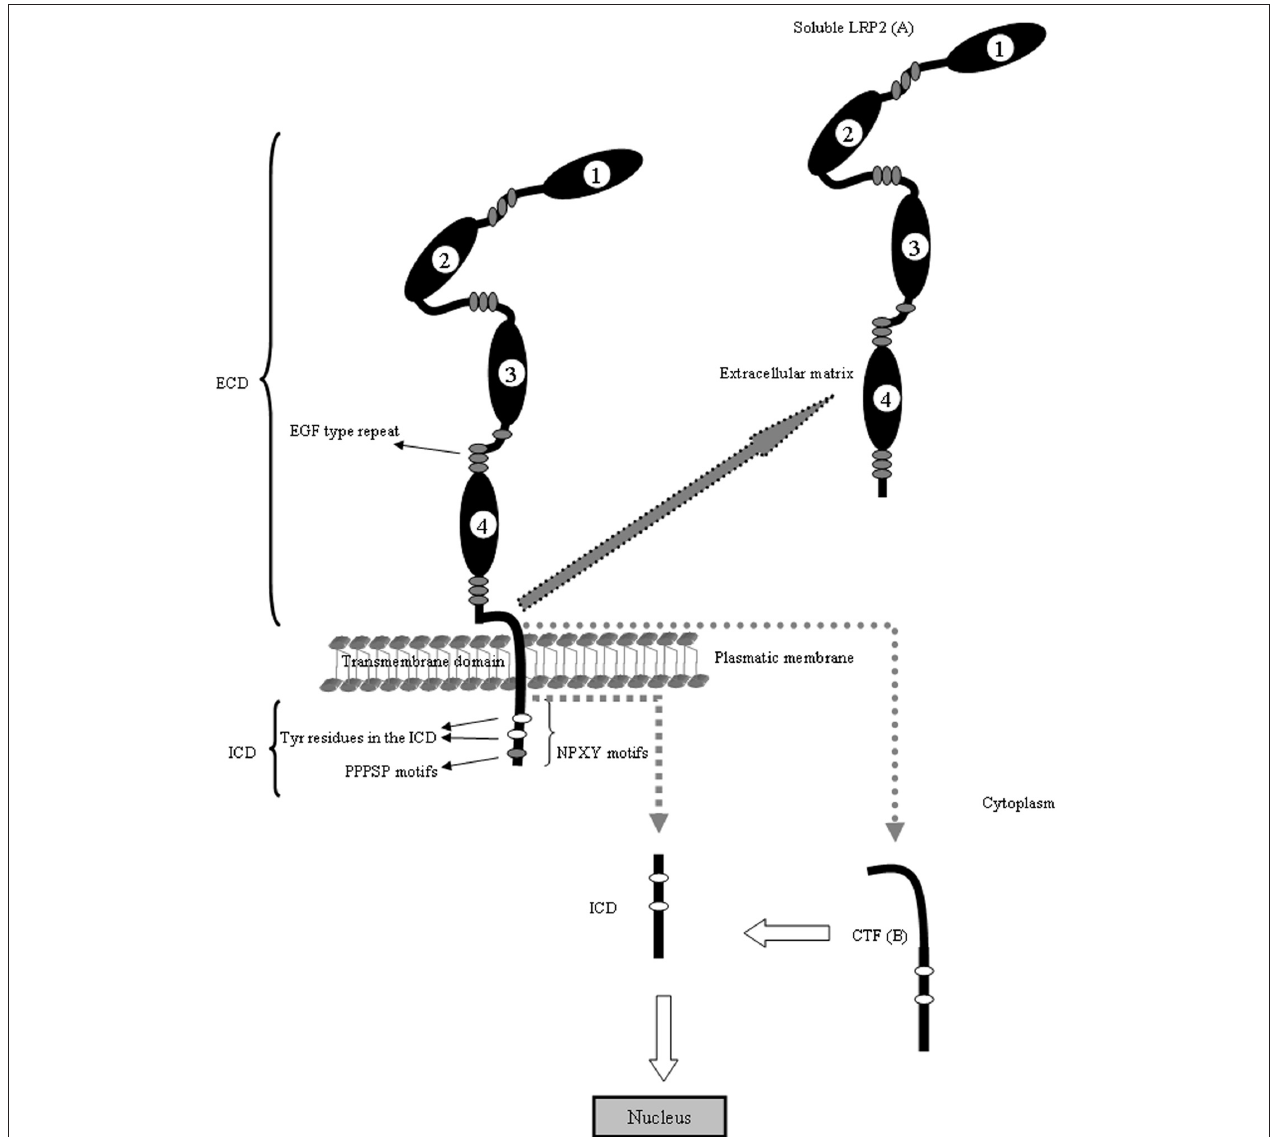
FIGURE 2 | LRP2 is structurally similar to LRP1. The ECD of LRP2 contains four clusters (1–4) of lipoprotein receptor ligand-binding repeats, growth factor repeats, an EGF repeat, and YWTD spacer regions. Interestingly, the second cluster has been identified as a common binding site for several ligands including Apo E, Apo M, retinol binding protein and transthyretin. The fourth cluster has been identified as binding site for A β . The LRP2 is also proteolytically cleaved to generate two subunits: (A) the N-terminal (soluble LRP2) containing the ligand-binding domains and (B) the C-terminal subunit containing an extracellular fragment (CTF), the transmembrane spanning domain and the ICD. The ICD contains diverse potential endocytosis and signaling motifs. The ICD binds adaptor proteins important for LRP2-mediated endocytoses, such as Dab2 and is able to induce intracellular events such as